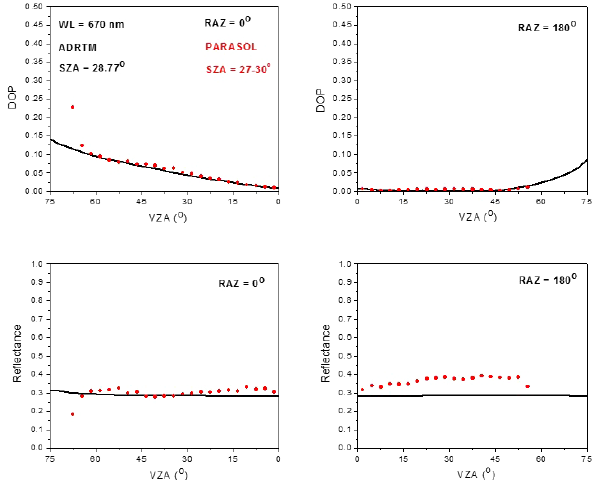
Figure 8. Comparison of the modeled DOP and reflectance of desert-reflected solar light at RAZs of 0 and 180 ◦ with those from the PARASOL data at the wavelength of 670nm. The SZA is 28.77 ◦ in the modeling. The SZA is in the bin of 27–30 ◦ for the PARASOL data.